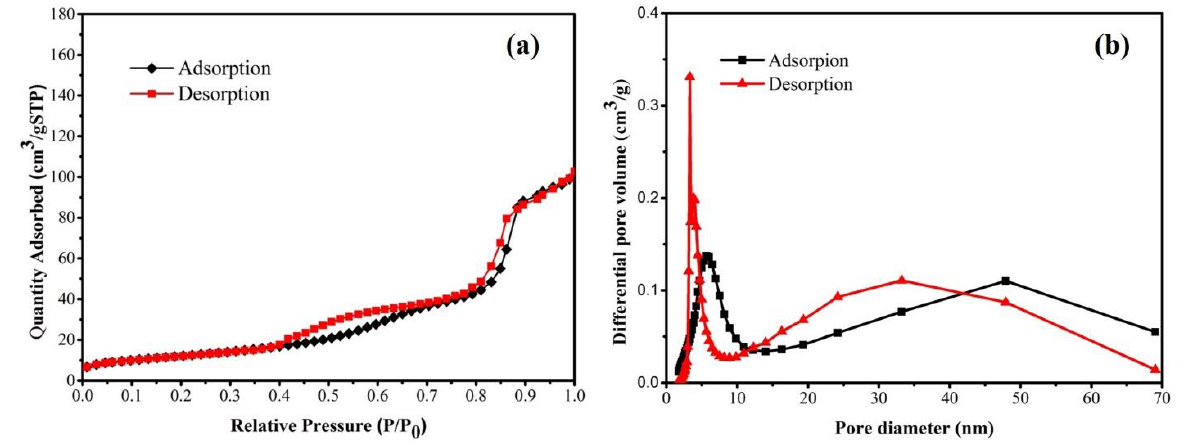
Figure 7. ( a ) BET and adsorption desorption plot for NiCdTiO 2 ( b ) BJH plot showing porosity evaluation of NiCdTiO 2 . Table 1. The specific surface area, pore size, pore volume and BJH average pore width of NiCdTiO 2 nanocomposite.